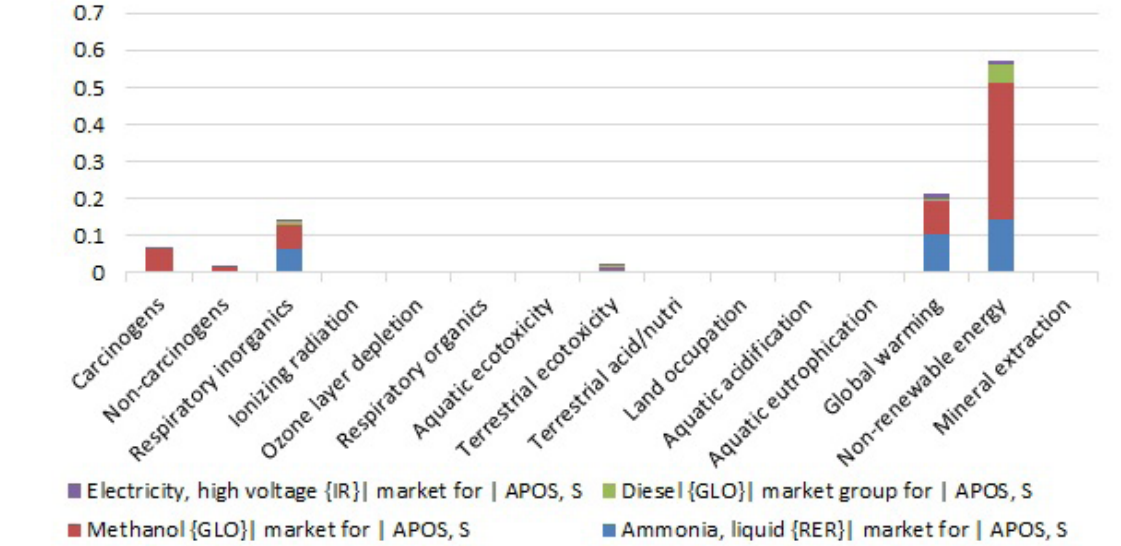
Figure 14. Results of applying weighting coefficients of the IMPACT 2002+ method in calculating impacts